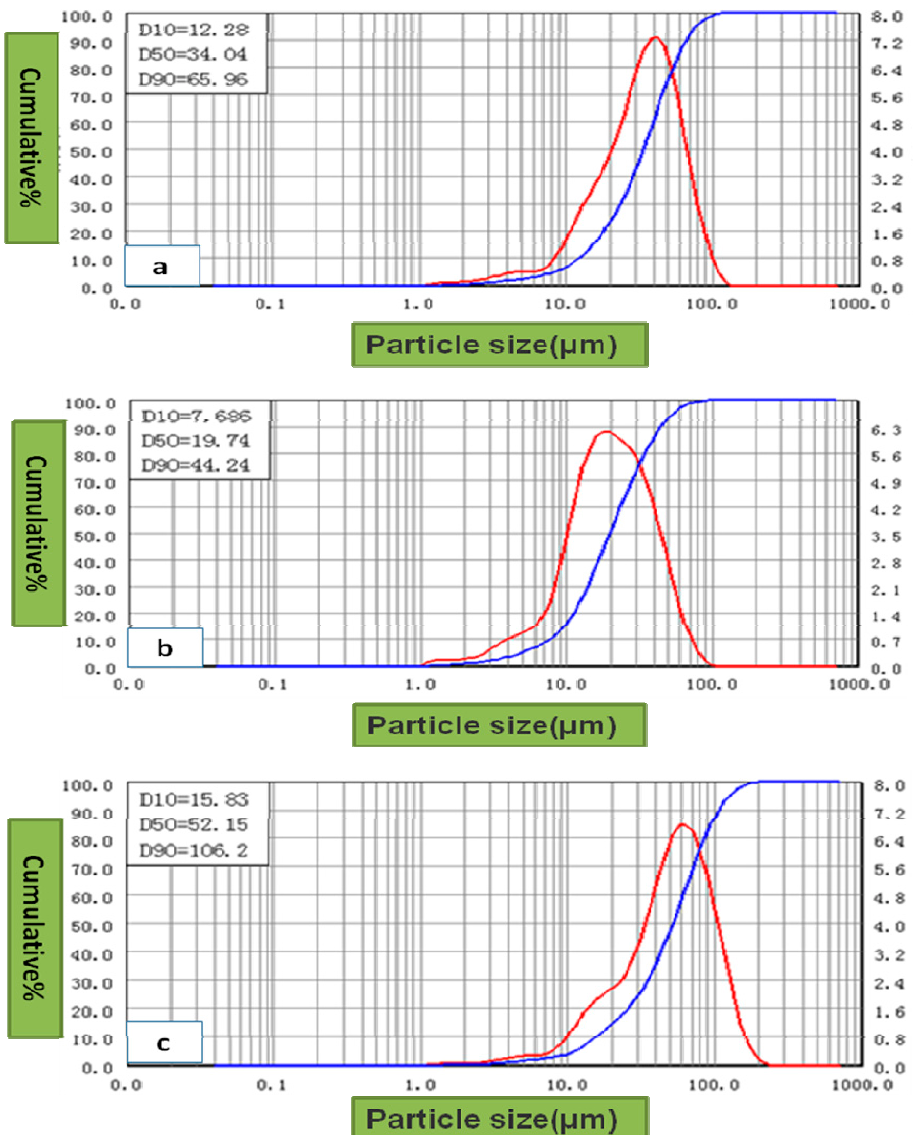
Figure 9. The particle size distribution of rhenium powder prepared by ammonium perrhenate with different particle sizes (( a ) prepared by 81.05 µm D 50 ammonium perrhenate, ( b ) prepared by 71.17 µm D 50 ammonium perrhenate, ( c ) prepared by 123.90 µm D 50 ammonium perrhenate).